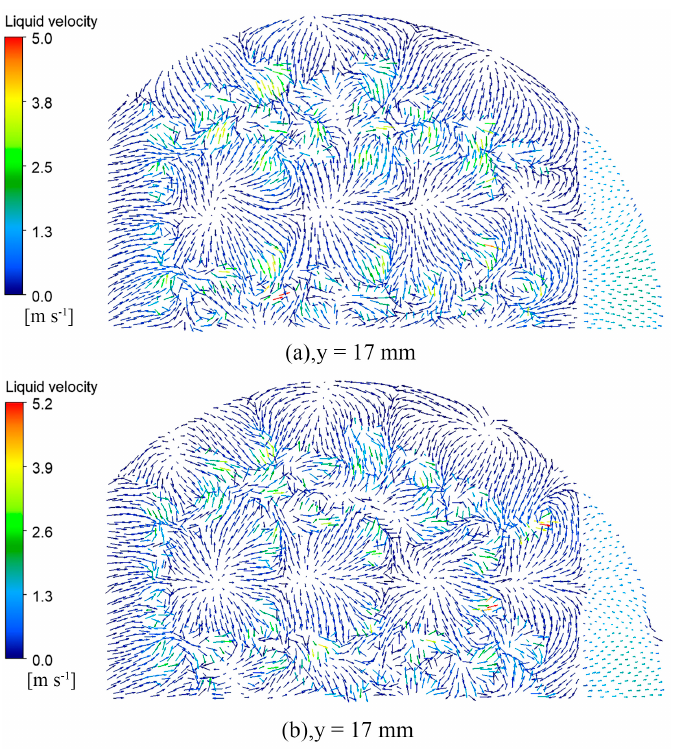
Figure 16. Liquid velocity vector snapshots of the top view at y = 17 mm: ( a ) rectangular guided valve tray; ( b ) parabolic–shaped guided valve tray.